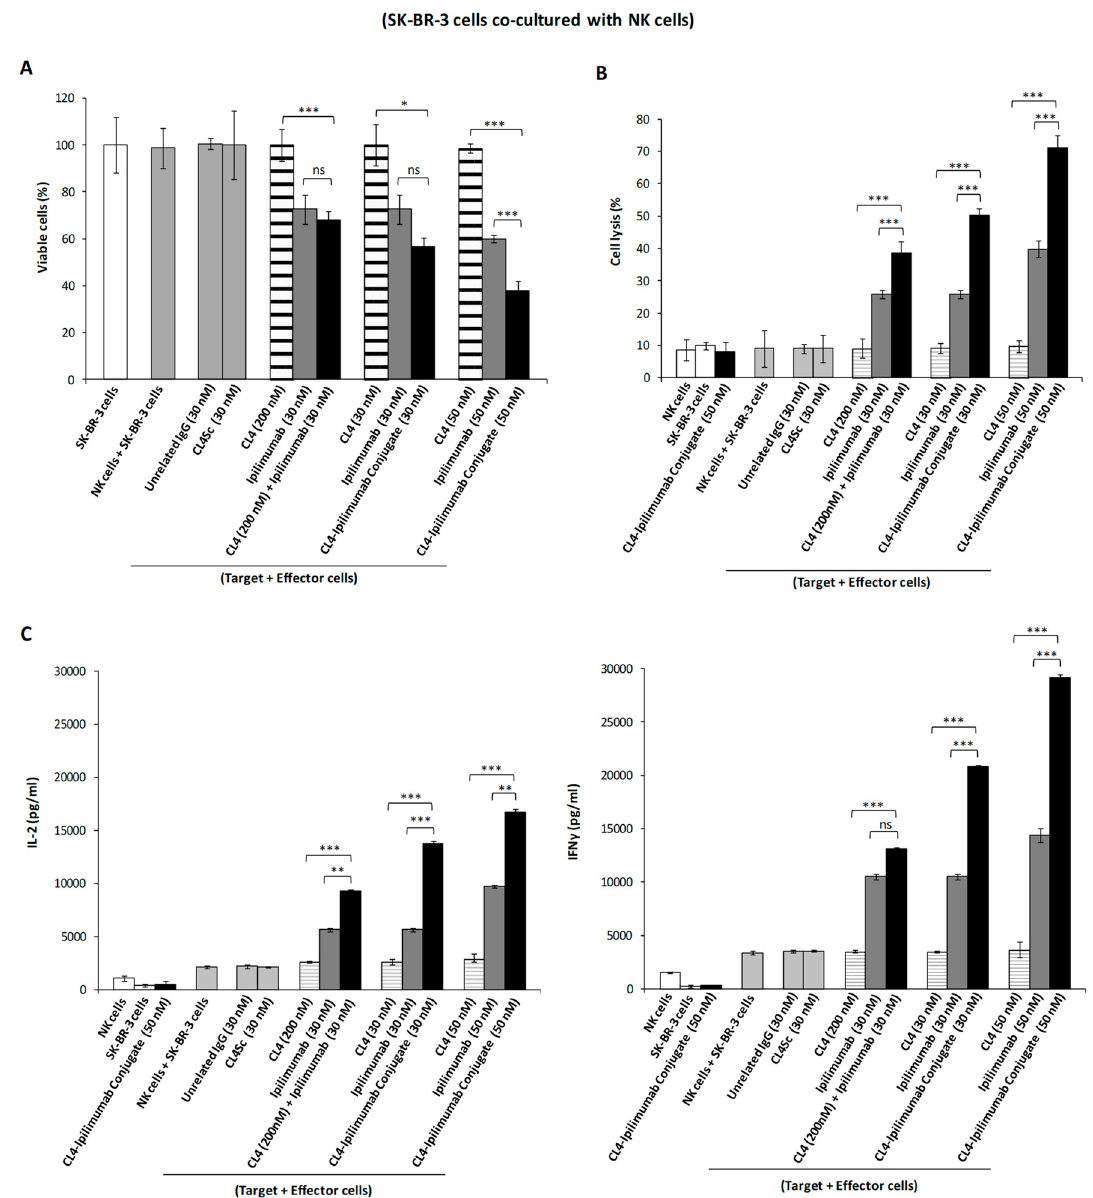
Figure 7. Cytotoxic e ff ects of CL4-ipilimumab conjugate on SK-BR-3 tumor cells co-cultured with NK cells. ( A ) SK-BR-3 cells were co-cultured with NK cells (e ff ector:target cells ratio: 3:1) and treated for 24 h with CL4 aptamer (striped bars), ipilimumab mAb (grey bars), their combination, or CL4-ipilimumab conjugate (black bars), as indicated. SK-BR-3 cells separately treated with the immunoconjugate, the scrambled aptamer, or with hPBMCs were included as controls. The percentage of viable cells is expressed with respect to untreated cells. ( B ) The release of lactate dehydrogenase was tested for measuring % cell lysis as described in Materials and Methods. ( C ) The levels of secreted IL-2 and IFN- γ were measured by ELISA on supernatants of cells treated, as indicated. Error bars depict means ± SD. p -values for the indicated treatments are: *** p ≤ 0.001; ** p < 0.01; * p < 0.05.